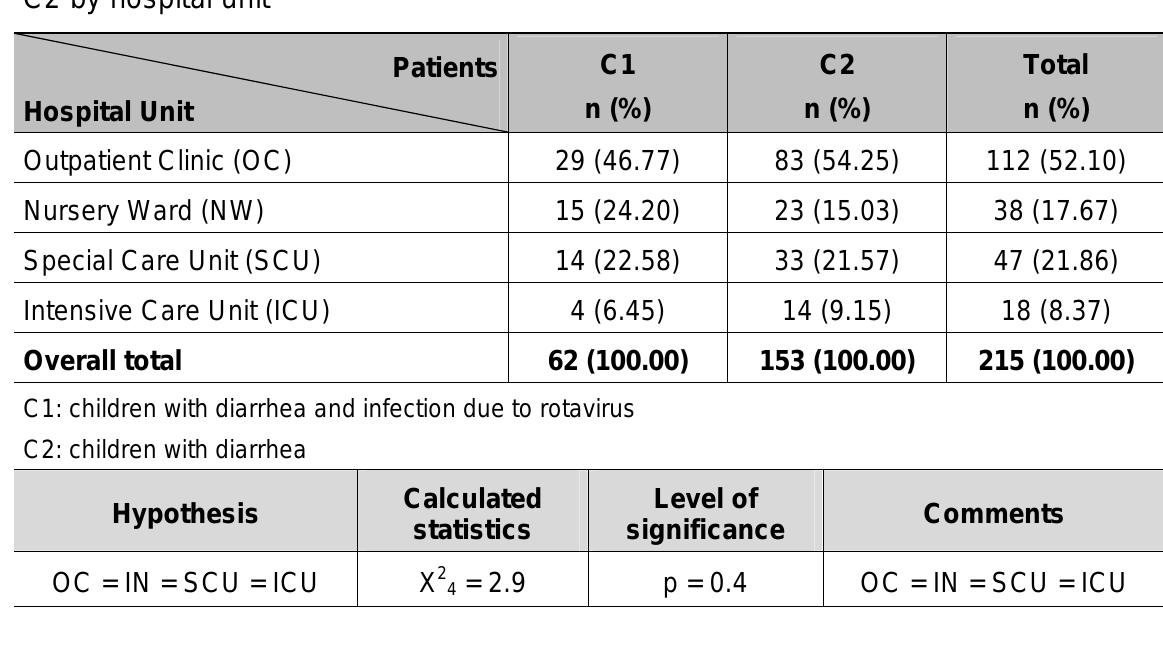
Table 2. Distribution of 215 children with craniofacial malformations of groups C1 and C2 by hospital unit